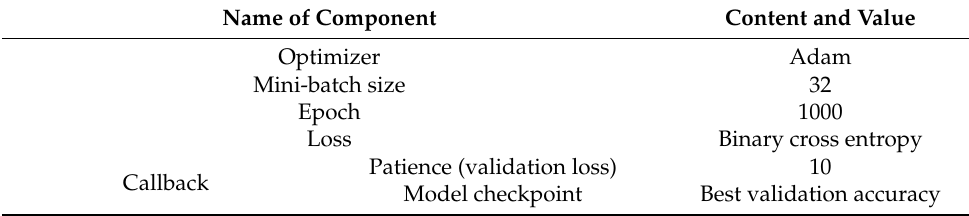
Table 2. Train Table 2. Train parameters.